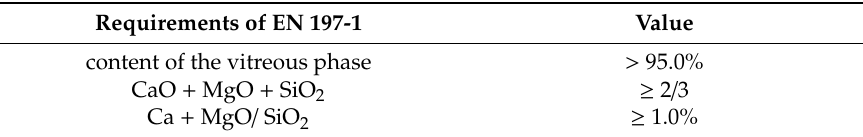
Table 9. The requirements of granulated blast furnace